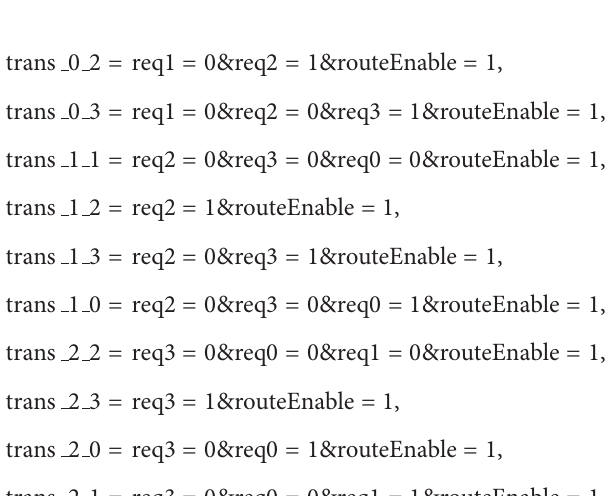
Figure 6: The behavior of